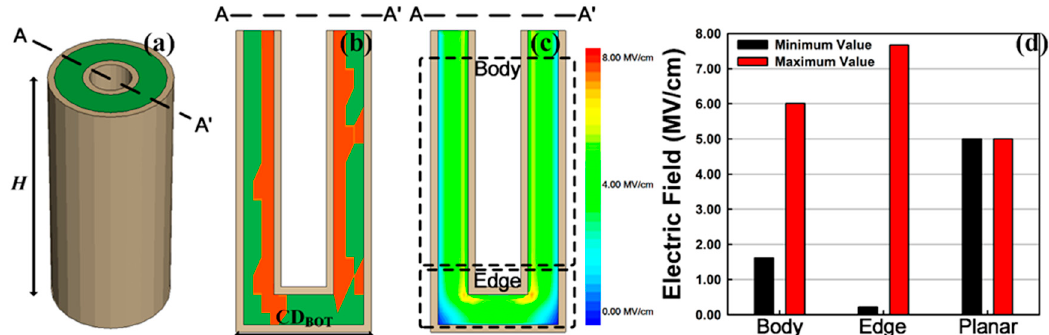
Figure 5. ( a ) Bird’s-eye view of the cylindrical structure. ( b ) Trap formation at the TDDB. The red region indicates generated traps. ( c ) Electric field contour ( V TOP = 1.0 V, without traps). ( d ) Summarized maximum and minimum electric fields in the body, edge, and planar ( V TOP = 1.0 V, without traps) cases.